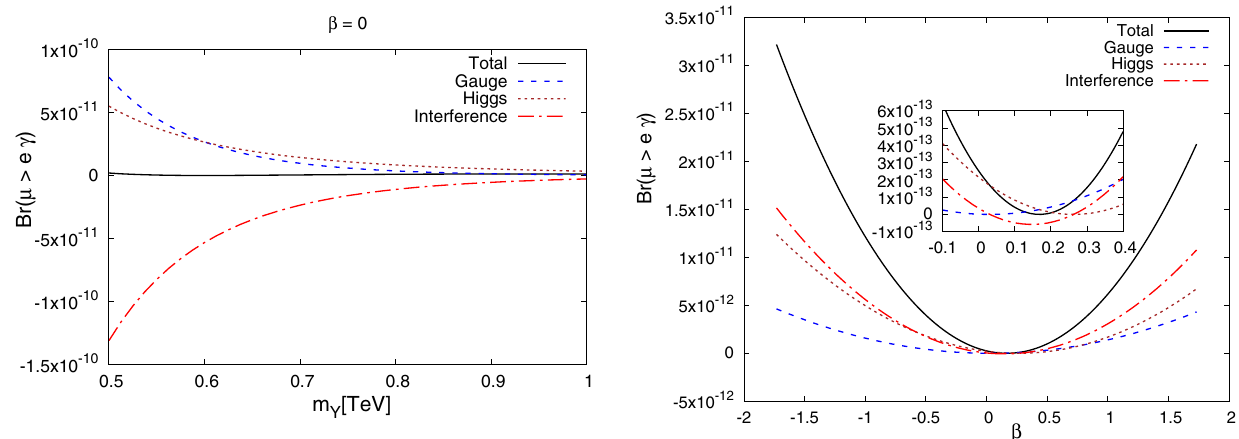
Fig. 5 Branching fraction of μ → e γ as a function of m Y (left) and of β (right). Gauge (blue), Higgs (brown) and interference (red) contributions are also separately shown. Total branching fractions are the black lines. Other parameters are fixed as given in the